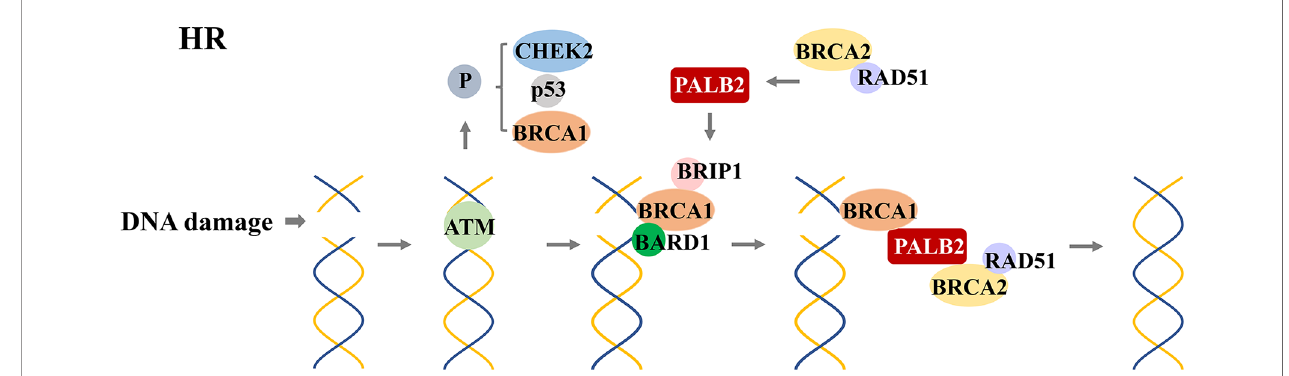
FIGURE 5 | RAD51 -mediated homologous recombination (HR) for DNA repair. After detecting DNA double-strand damage, ATM is recruited and activated, leading to the phosphorylation of downstream effectors, including BRCA1 , p53 , and CHEK2 . After phosphorylation, BRCA1 and BRAD1 form a heterodimer; BRIP1 interacts with BRCT repeats; which constitute a scaffold to recruit BRCA2 , PALB2 , and RAD51 to form a complex. This complex locates the DNA damage site and promotes the HR